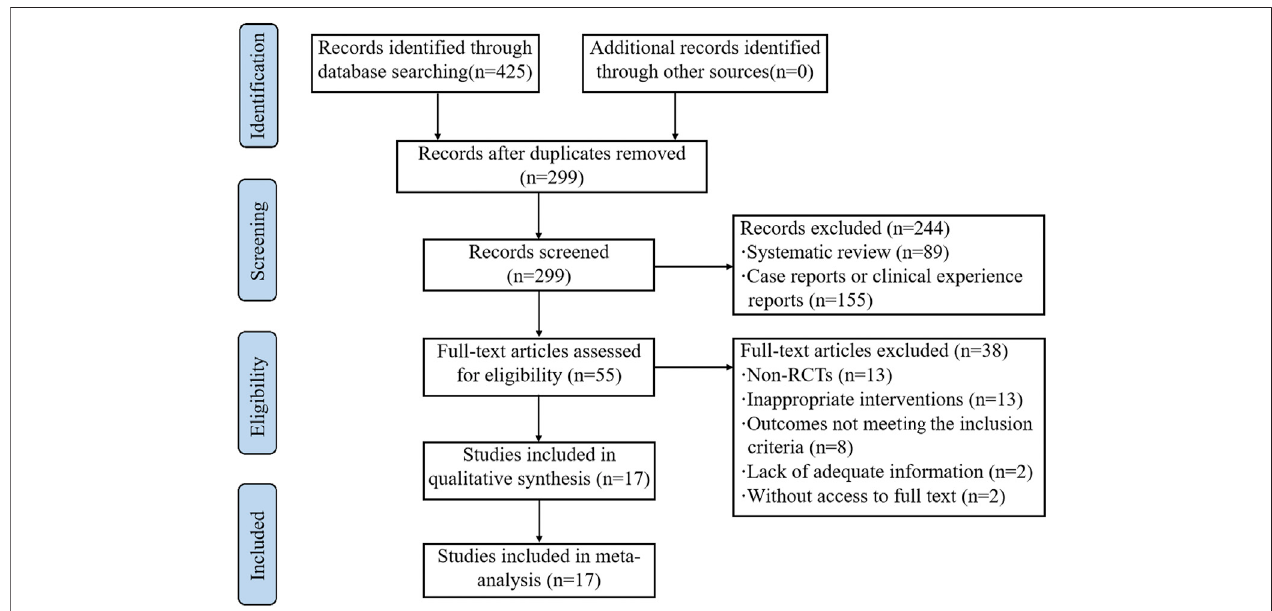
FIGURE 1 | PRISMA fl ow diagram of the literature search